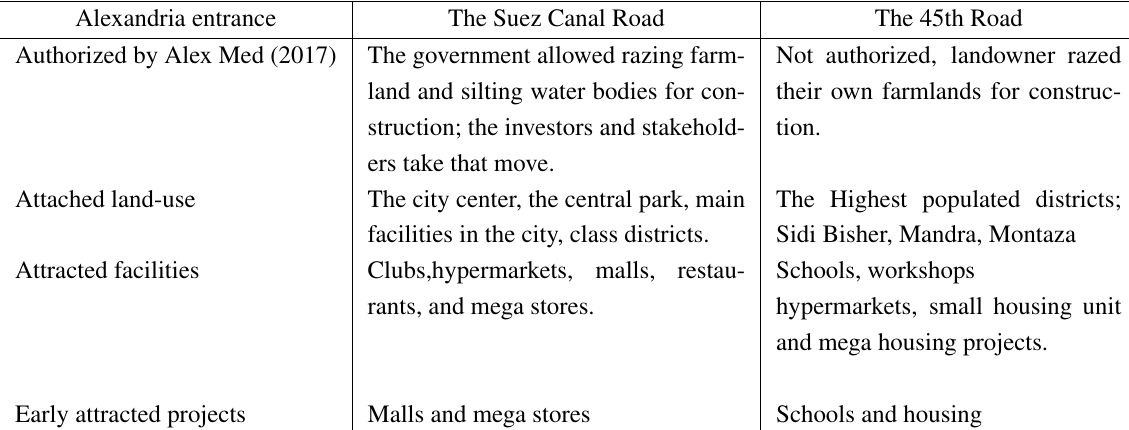
Table 1. The economic formation at Alexandria City